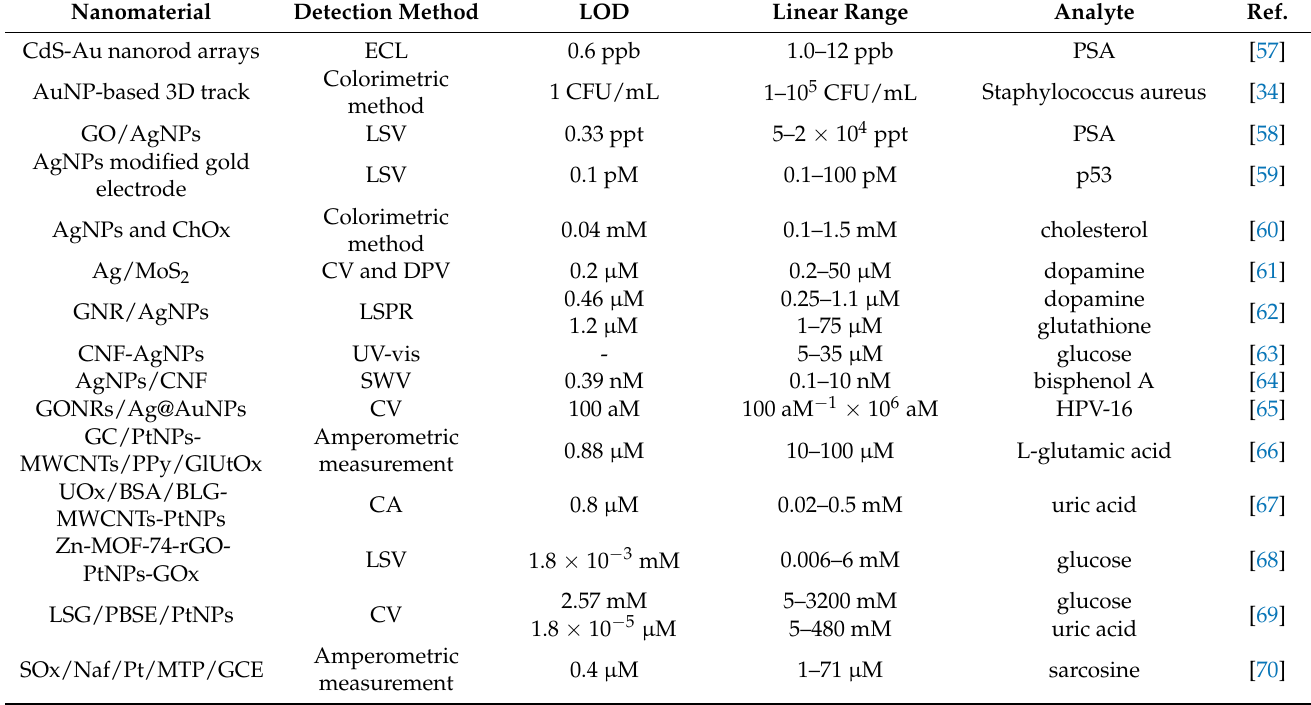
Table 1. Metallic nanomaterials biosensors for biomedical